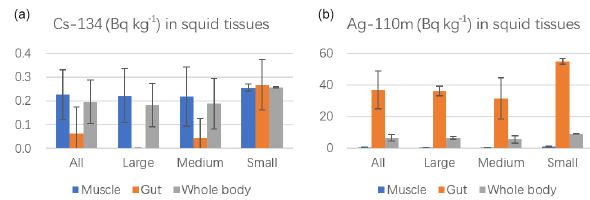
Figure 2. Activity concentrations of Cs-134 (a) and Ag-110m (b) in squid tissues.